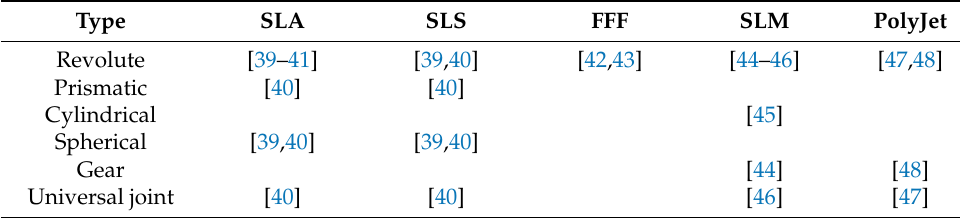
Table 2. Non-assembly additively manufactured kinematic pairs and